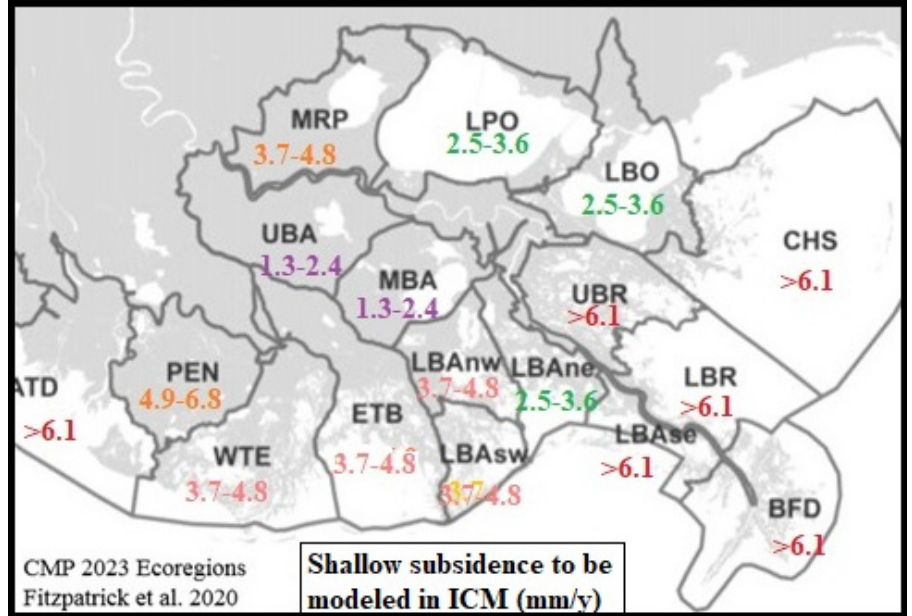
Figure 16. Ecoregion polygons for the 2023 CMP with shallow subsidence (SS) ranges in each for modeling marsh sustainability [17]. Newly proposed ecoregion boundaries partition Biloxi Marsh study area four ways, including portions of Lake Borgne (LBO), Chandeleur Sound (CHS), Upper Breton (UBR) and Lower Breton (LBR) polygons.